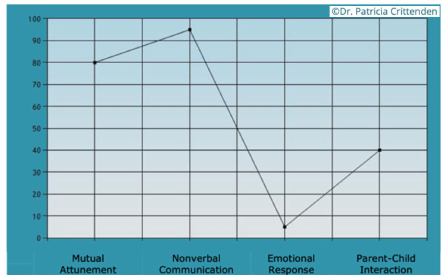
Figure A3. Joanna and Mrs. Townsend.